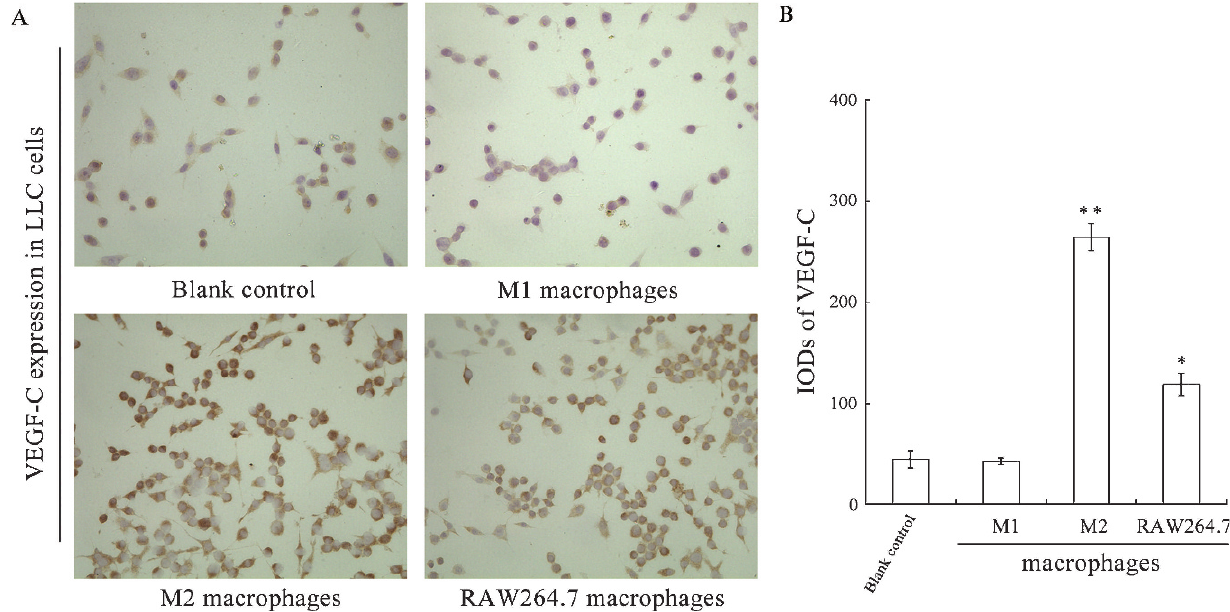
Figure 3 - VEGF-C expression by LLC cells induced following exposure to activated macrophages. (A) VEGF-C could be detected in the blank control and in the M1, M2, and RAW264.7 macrophage co-cultured groups. (B) Comparison of the IODs for VEGF-C. The data shown represent three experiments. * p , 0.05 and ** p , 0.01 compared to the